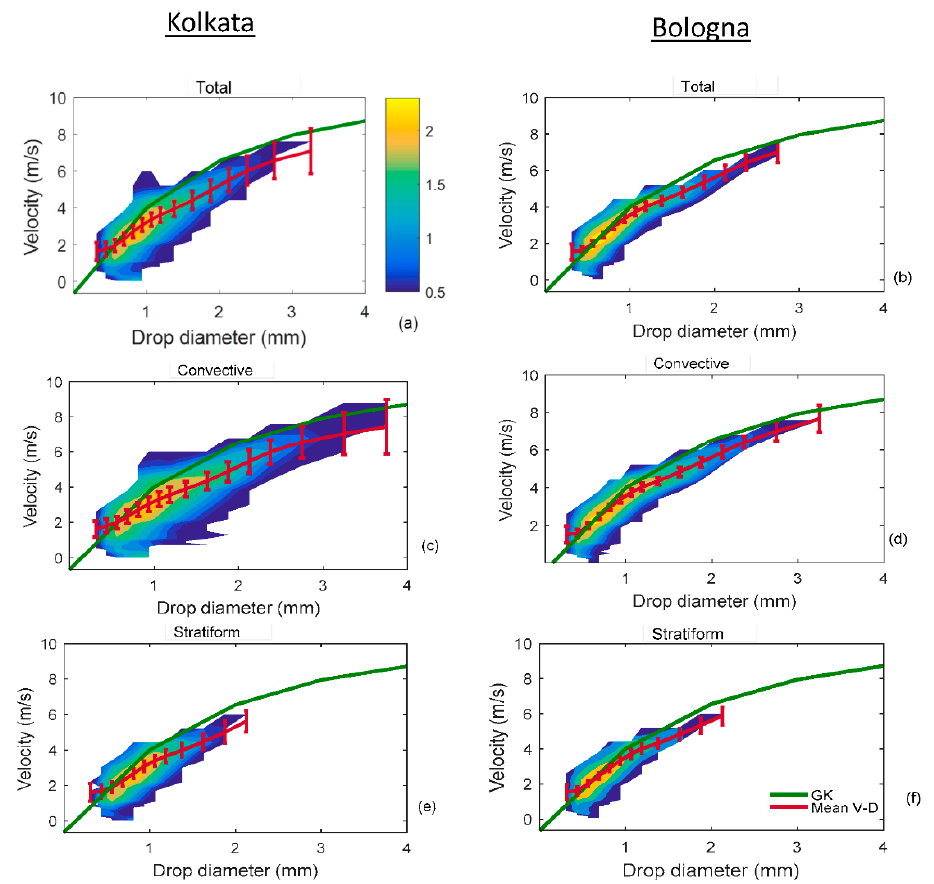
Figure 3. Spread of velocity–diameter spectra for the whole dataset in ( a ) Kolkata and ( b ) Bologna; for convective rain in ( c ) Kolkata and ( d ) Bologna and for stratiform rain in ( e ) Kolkata and ( f ) Bologna. The colors represent the number of drops on the log 10 scale. In the x- and y-axis, the diameters and velocities are sampled with the original Parsivel2 classes. The green line is the GK line, and the red line is the mean of the V-D relationship observed for the dataset with the standard deviations shown as error bars.